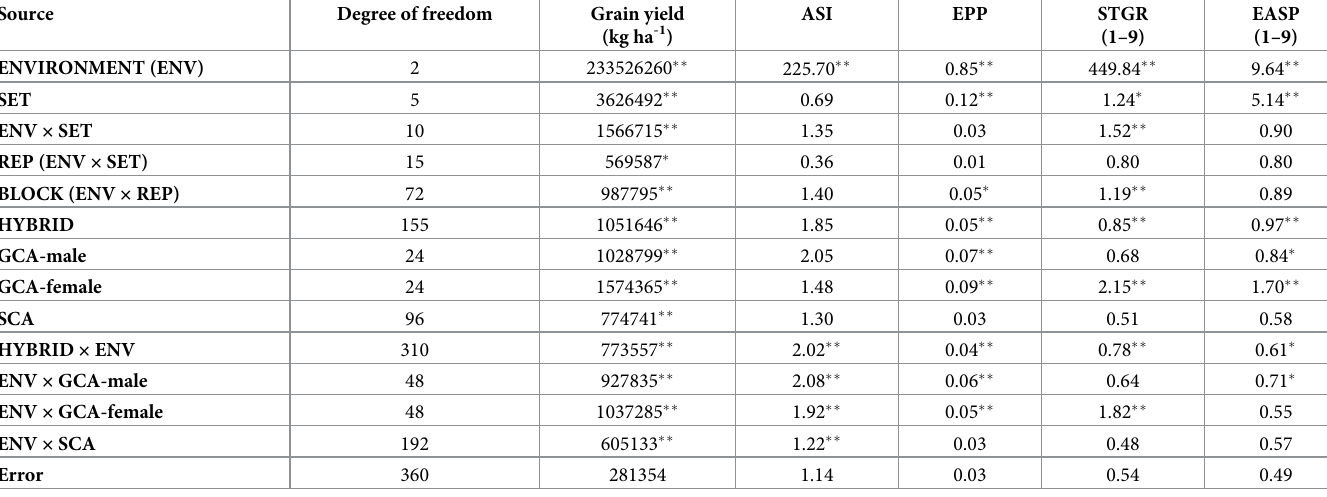
Error ASI = Anthesis-silking interval, EPP = number of ears per plant, STGR = Stay green characteristic, EASP = Ear aspect, GCA-male = general combining ability of male, GCA-female = general combining ability of female, SCA = specific combining ability � , �� = Significant at 0.05 and 0.01 probability levels, respectively.